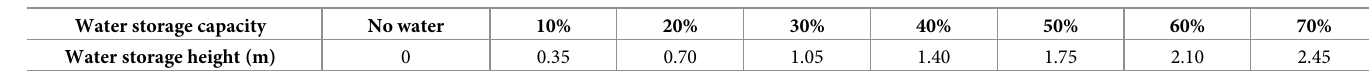
Table 4. The Corresponding relationship between water storage capacity and water storage height. Water storage capacity